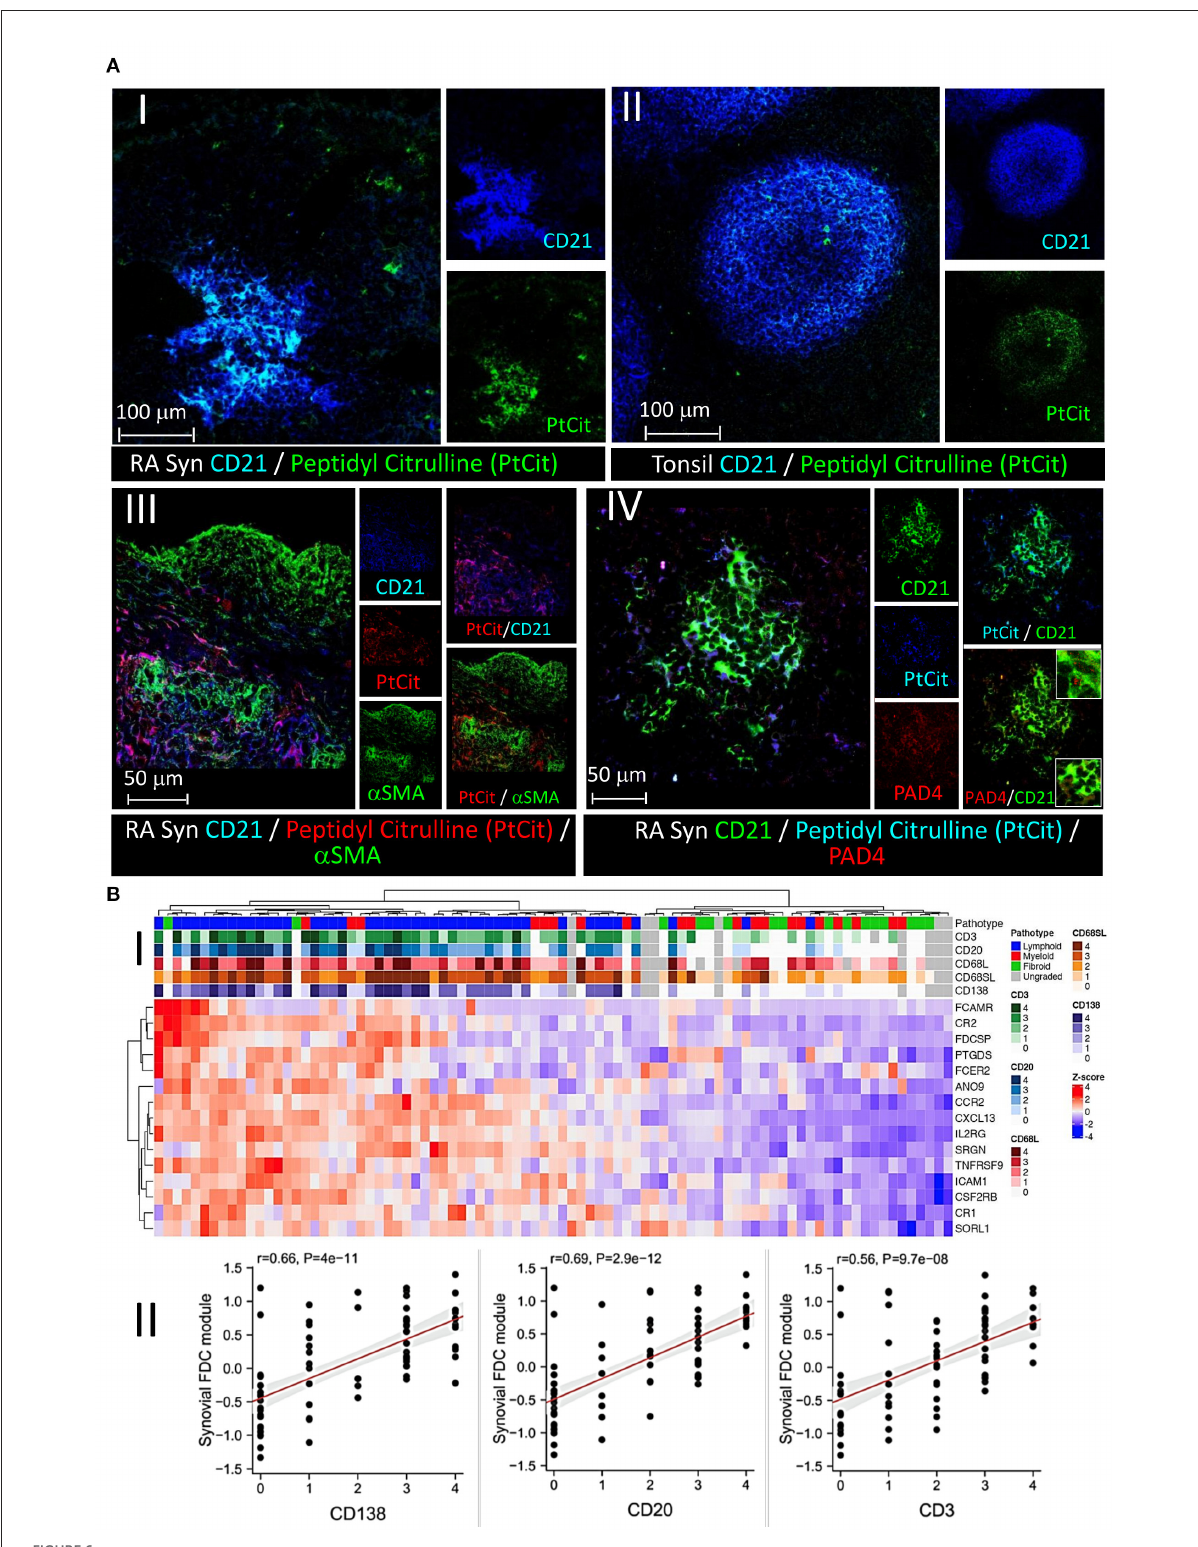
FIGURE6 Retention of peptidyl citrulline on synovial FDCs and correlation of the FDC gene module with synovial pathotypes and cellular infiltrates . (A) Colocalization of peptidyl citrulline with FDCs in the synovial tissues (A-I) , and tonsillar control (A-II) . (A-III,IV) peptidyl citrulline trapping